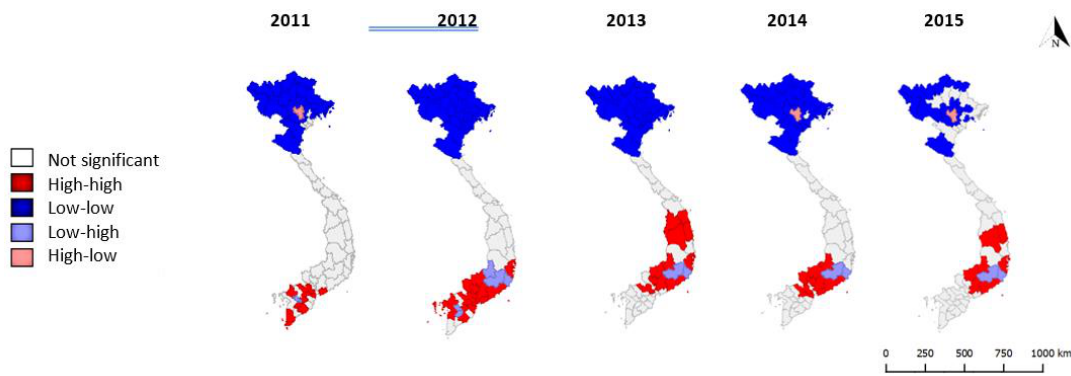
Figure 3. High-high and low-low clusters and outliers (high amongst low or low amongst high) of dengue cases per 100,000 population, first order queen contiguity, 2011–2015.